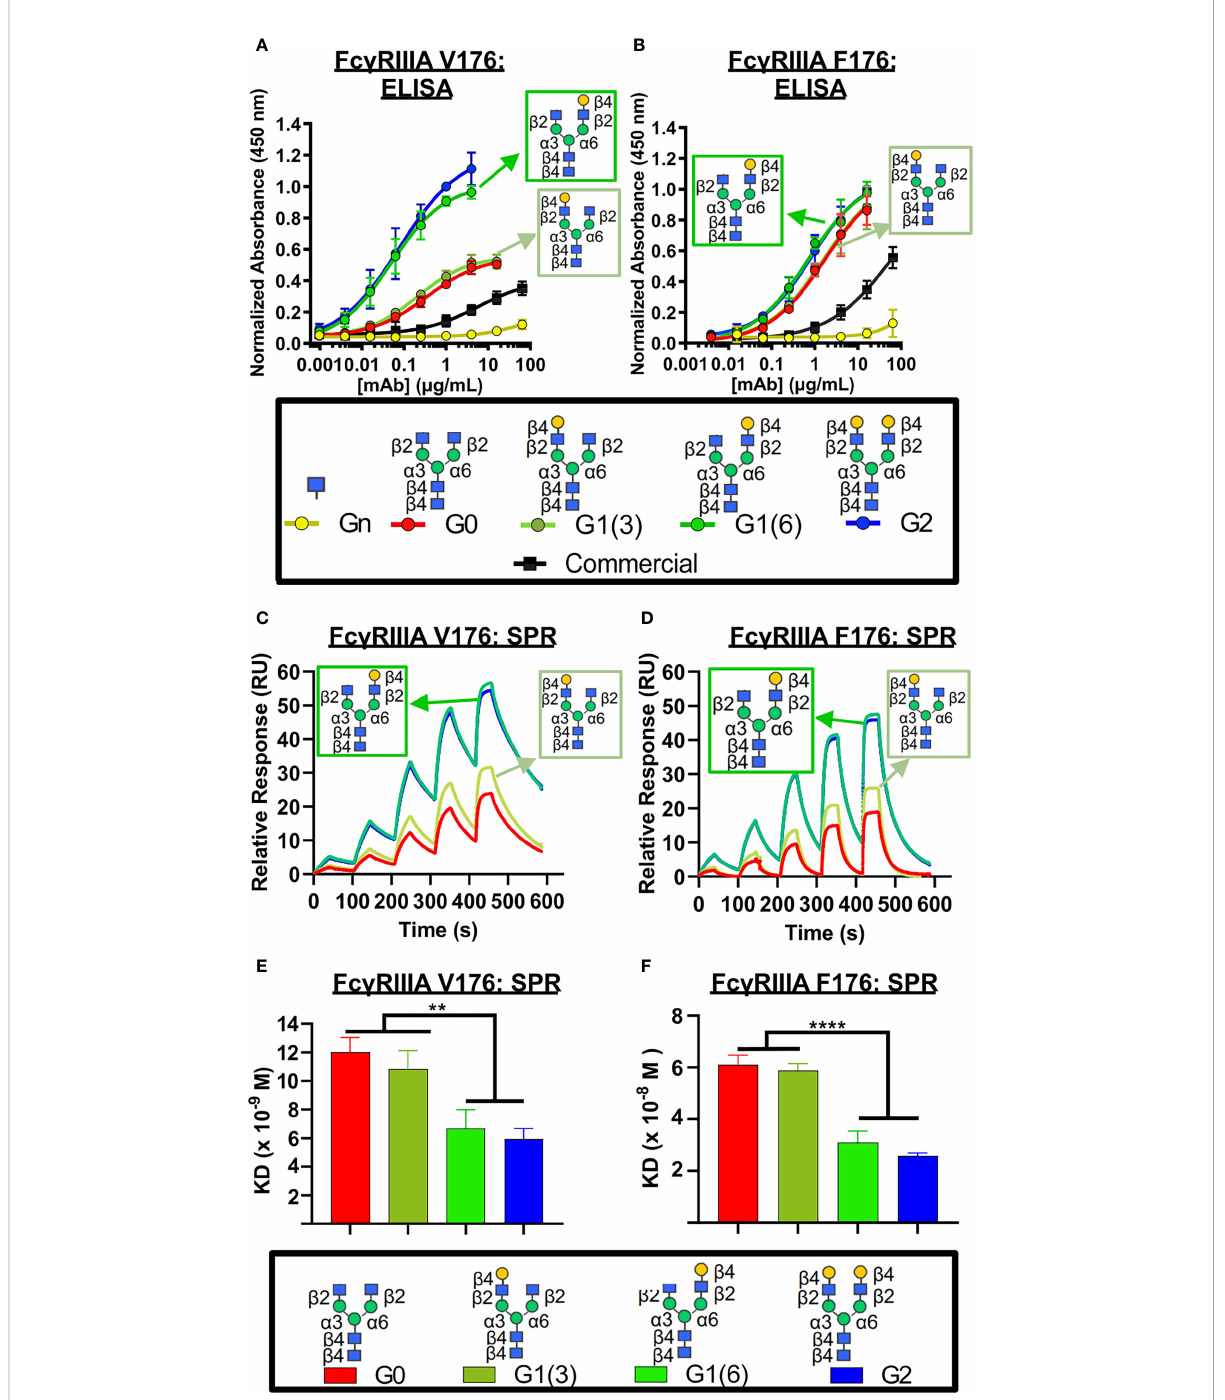
FIGURE 3 Fc g RIIIa (CD16A) binding shows galactose on the a 6 antenna signi fi cantly affects activity – 2D binding assays. (A,B) Dose response curves are obtained in the various glycoform analogues in an ELISA assay. (A) CD16A V 176 (high af fi nity) or (B) CD16A F176 (low af fi nity) were coated, followed by mAb binding. An anti-human Fab-HRP antibody, and Ultra-TMB were used for detection at 450 nm. Error bars show mean ± standard deviation (n=4 replicates); non-linear regression (variable slope, four parameters) was used for curve- fi tting in GraphPad. (C-F) Surface Plasmon Resonance (SPR) of each palivizumab glycoform for either (C, E) CD16A V176 or (D, F) CD16A F176. (C, D) Overlaid sensograms and (E, F) dissociation constant (KD, M) are shown. For ( E, F ), error bars show mean KD ± standard deviation from 3 replicate binding experiments; **p < 0.01; ****p <0.0001, one-way ANOVA, Tukey post-hoc